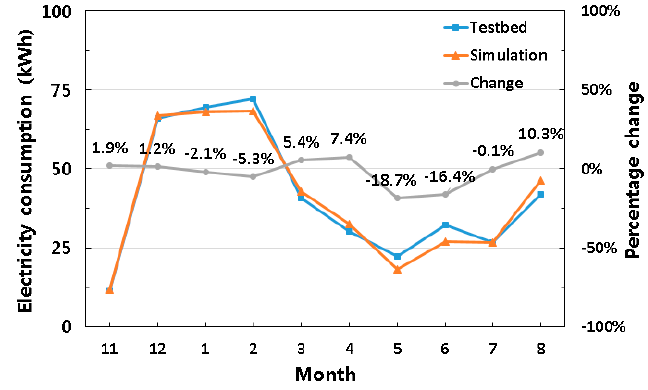
Figure 10. Case 3: Anseong weather data + two-speed operation heat pump.